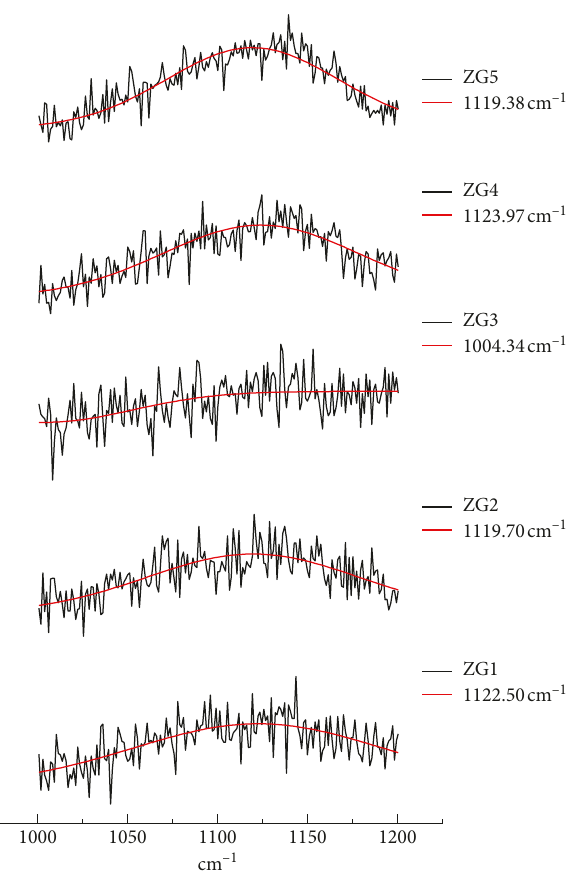
Figure 4: Raman spectroscopy measurements of samples ZG1, ZG2, ZG3, ZG4, and ZG5 for the range corresponding to the 2-LO phonon mode, showing a redshift from 1158cm − 1